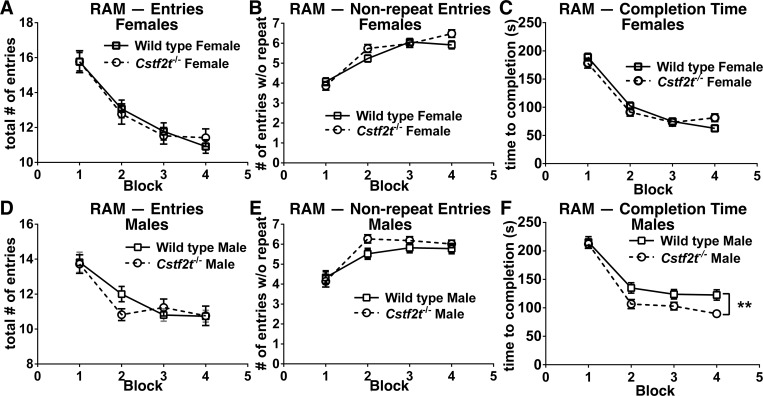
Female wild type and Cstf2t-/- mice display similar working and spatial memory as assessed by 8-arm radial arm maze (RAM).Male and female Cstf2t-/- and wild type mice were run in a RAM once per day in five-day blocks with two days break between blocks for four weeks. (A and D) Comparison of (A) female and (D) male performance using “total # of entries,” an indicator of overall accuracy of learning and memory showed no significant differences between groups (2-way ANOVA (F (3, 1146) = 6.836; p<0.001)). A post-hoc Tukey’s multiple comparison test confirmed no differences between female and male Cstf2t-/- and wild type groups, but indicated significant differences between female and male groups. (B and E) Comparison of (B) females and (E) males using the “total # of entries without error” metric, an estimate of memory span and, in turn, an estimate of working memory showed no significant differences between groups (2-way ANOVA (F (3, 1154) = 1.901; p = 0.13)). (C and F) Comparison of all groups examining “time to completion” of the maze task showed significant differences between groups in the “time to completion” metric (2-way ANOVA (F (3, 1151) = 27.99; p<0.0001)). A post-hoc Tukey’s multiple comparison test revealed no significant differences between (C) females, but revealed significant differences in (F) male wild type and Cstf2t-/- mice (**p<0.001). All data are presented as mean ± SEM. ANOVA analyses were conducted using all groups.